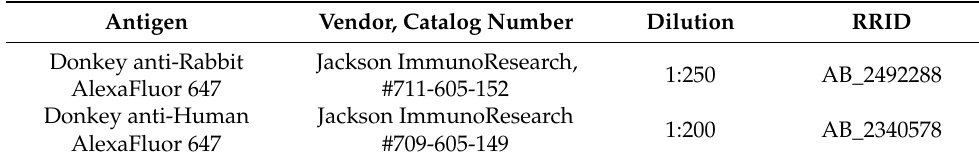
Table 4. Secondary antibodies used in